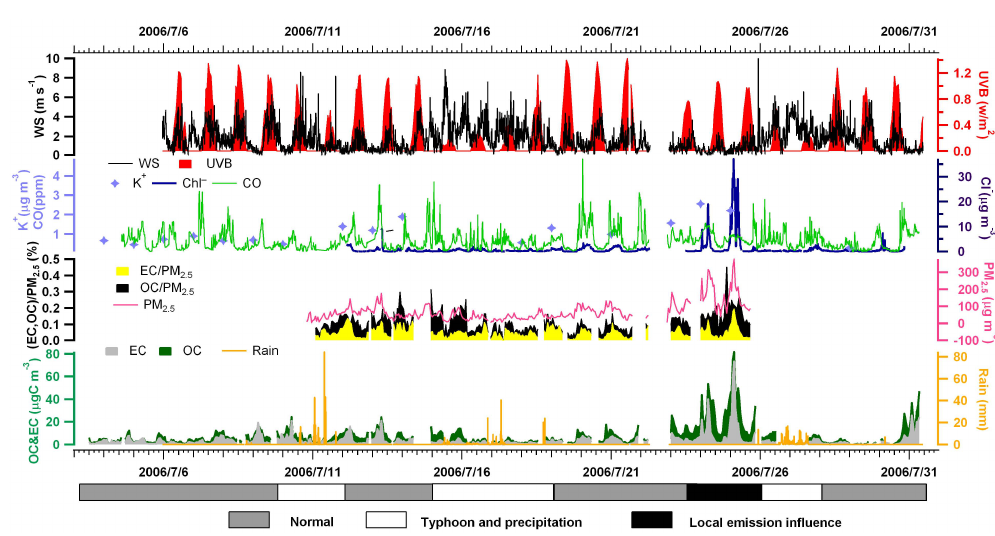
Fig. 3. The time series mass concentrations of PM 2 . 5 , EC, OC, Cl − , K + and meteorology conditions during PRIDE-PRD 2006 campaign. The whole campaign was divided into three typical periods: normal days (grey bar), typhoon and precipitation days (white bar), and local emission influence days (black